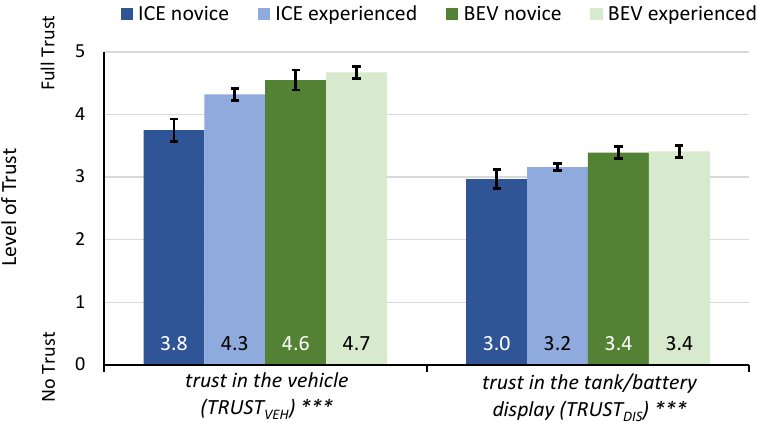
Figure 4. Trust in the vehicle and in the tank/battery display, differentiated by experience group (Means and related Standard Errors, scale min = 0, scale max = 5, *** corresponds to p <